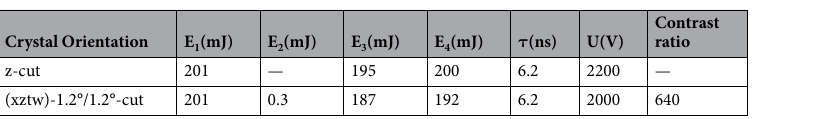
Table 1. Output results of the two pulse-on LN EO Q-switched Nd:YAG lasers. “—” mean that there is no energy was detected with an energy meter whose range is 0~200 μ